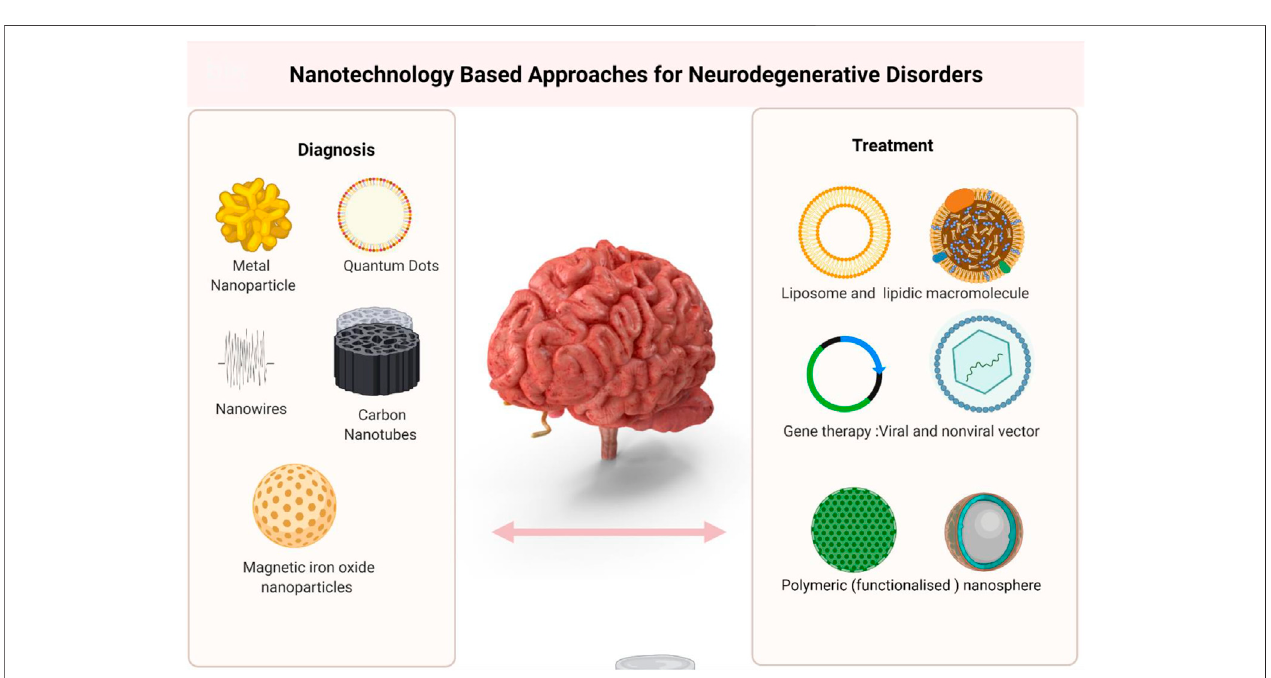
FIGURE 2 | Different form of NPs and their Application to treat and control Neurological Disorder.